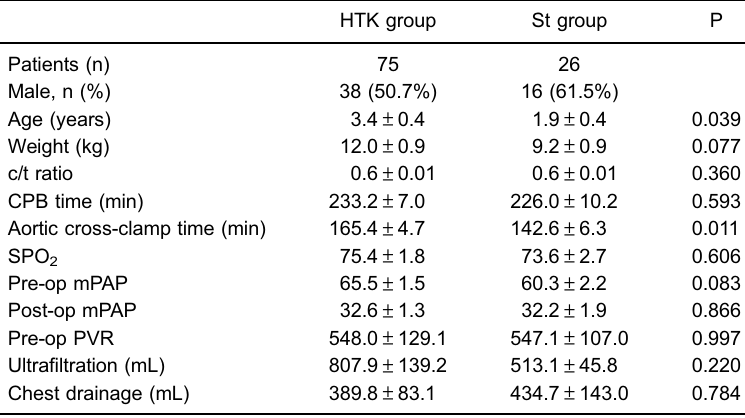
Table 2. Demographic and operative data of patients who underwent cardiac surgery with histidine-tryptophan-ketoglutarate (HTK) and St. Thomas ’ (St) cardioplegic